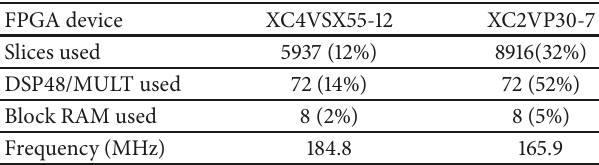
Table 3: Implementation results of